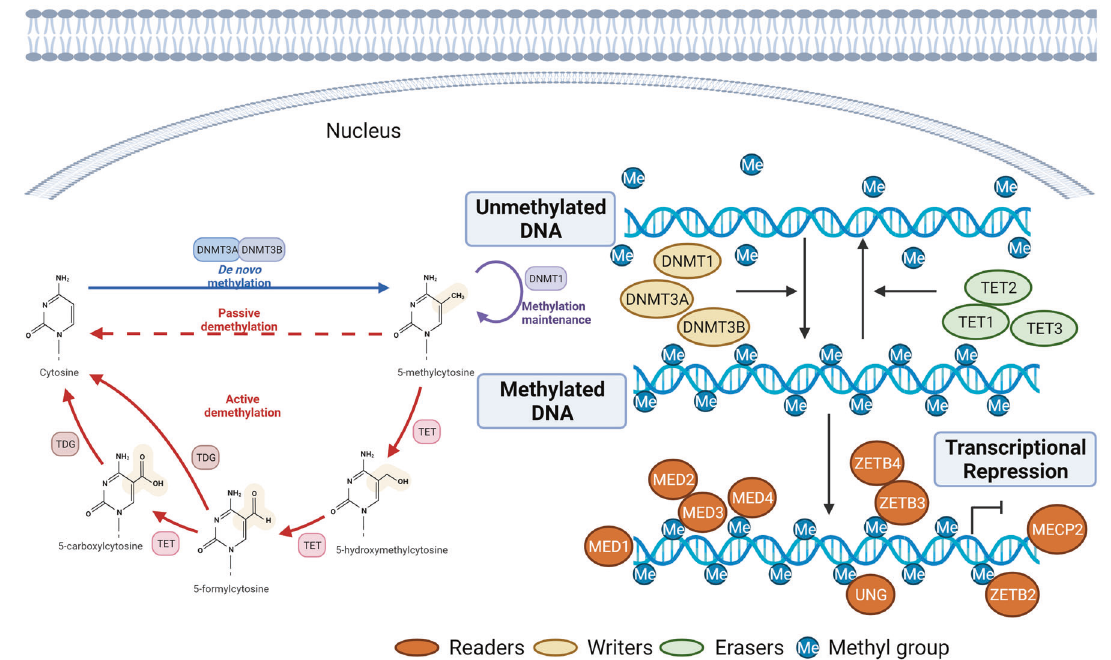
Fig. 1 DNA methylation regulation. DNA methylation occurs mainly in the islands of cytosinephosphateguanine (CpG) gene promoter region. It promotes gene transcription in the promoter region by activating DNA methyltransferases. DNA methylases can be divided into three categories according to their roles in DNA methylation: writing enzymes, erasing enzymes, and reading enzymes. Writing enzymes catalyze the addition of methyl groups to cytosine residues. The function of erasing enzymes is to modify and remove methyl groups. Reading enzymes can recognize and bind methyl groups to affect gene expression. This fi gure was created with the aid of Biorender (https://biorender.com/). DNMTs DNA methyltransferases, MBD methyl-CPG-binding domain, ZBTB zinc fi nger and broad complex, tramtrack, and bric a brac, TET Ten Eleven Translocation, MECP2 methyl-CpG-binding protein 2, UNG uracil – DNA